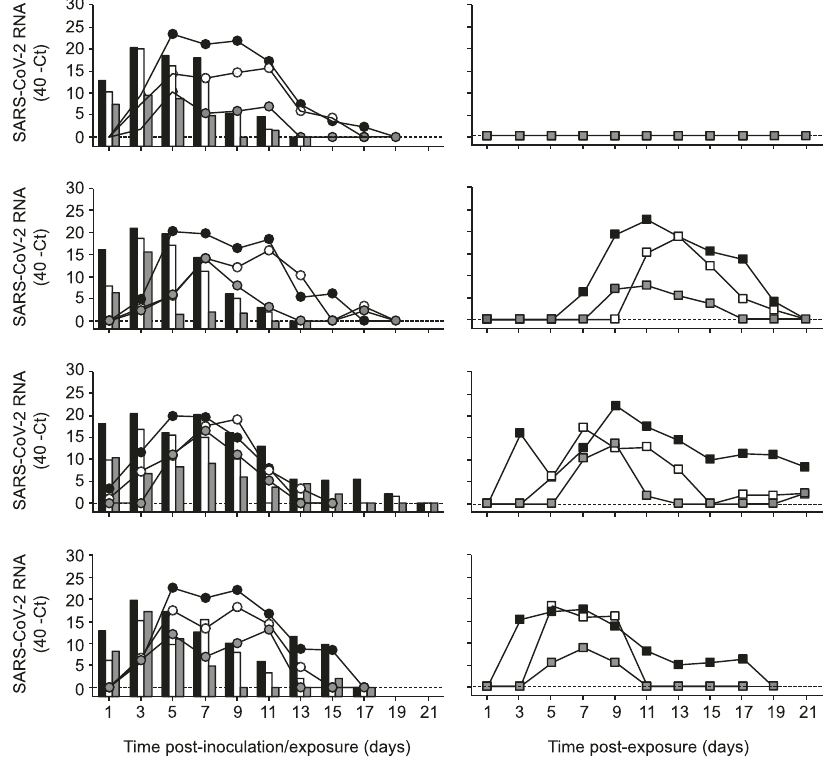
Fig. 2 SARS-CoV-2 shedding in ferrets in the transmission experiment. SARS-CoV-2 viral RNA was detected by RT-qPCR in throat (black), nasal (white) and rectal (grey) swabs collected from inoculated donor ferrets (bars; left panels), direct contact ferrets (circles; left panels) and indirect recipient ferrets housed in separate cages (squares; right panels). Swabs were collected from each ferret every other day until no viral RNA was detected in any of the three swabs. The dotted line indicates the detection